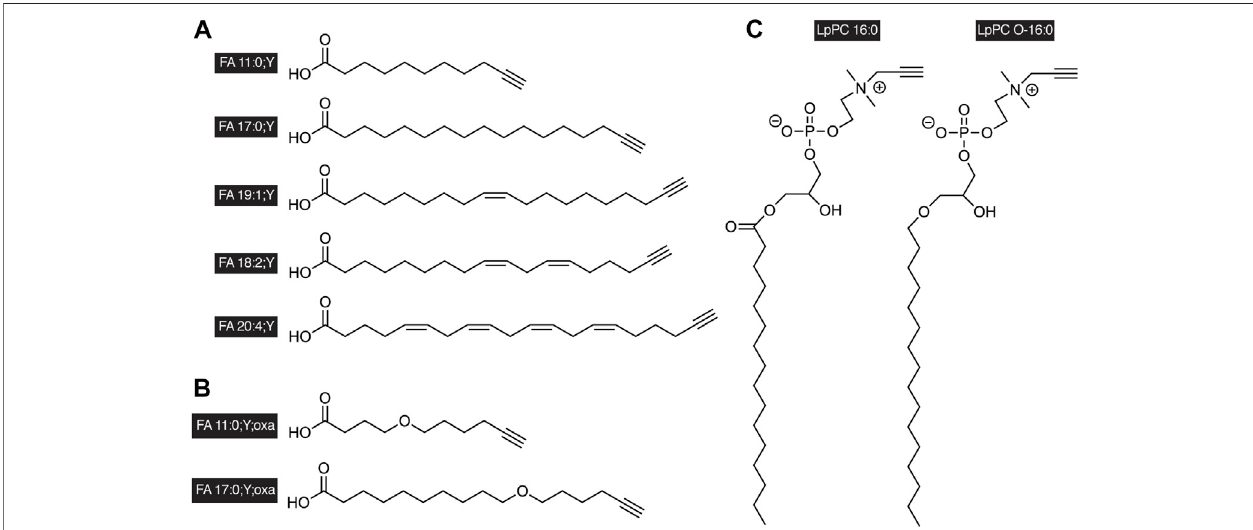
FIGURE1 | Examplesof alkyne-labeled lipids. Aterminal triple bond serves asa tag in the sidechainsof (A) alkyneFAs, (B) oxaalkyne FAs, or in the head group of (C) glycerophosphopropargylcholines. The short nomenclature treats the triple bond asfunctionalization of the FA as indicated by the suf fi x “ ;Y ” analogous to a carbon- by-oxygen-replacementdenotedby “ ;oxa. ” Thepropargylcholineheadgroupisdescribedbythelowercase “ p ” inthenameofthelipidclass.Itistobenotedthatalkyne- labeled lipids of various chain length and saturation degrees have been described, both with odd or even carbon counts in the